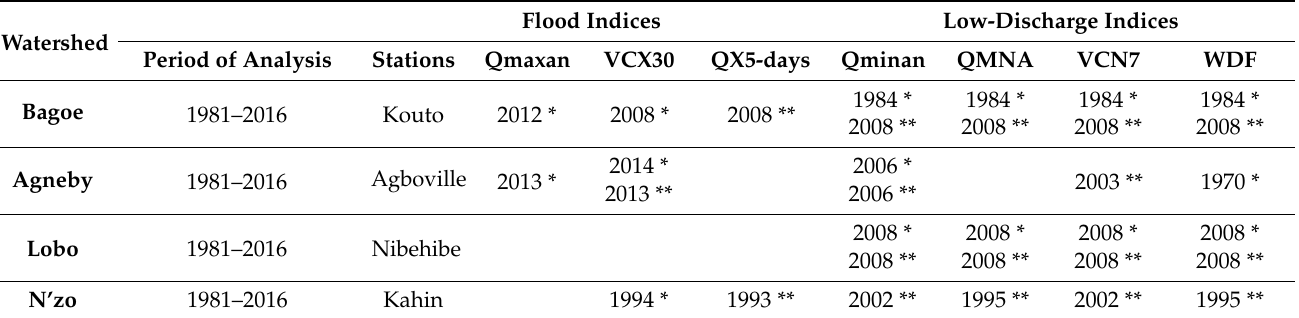
Table 6. Break point detection related to the heterogeneous and homogeneous periods for flood indices and low-discharge indices in the selected river watersheds in C ô te d’Ivoire for the period 1981–2016.